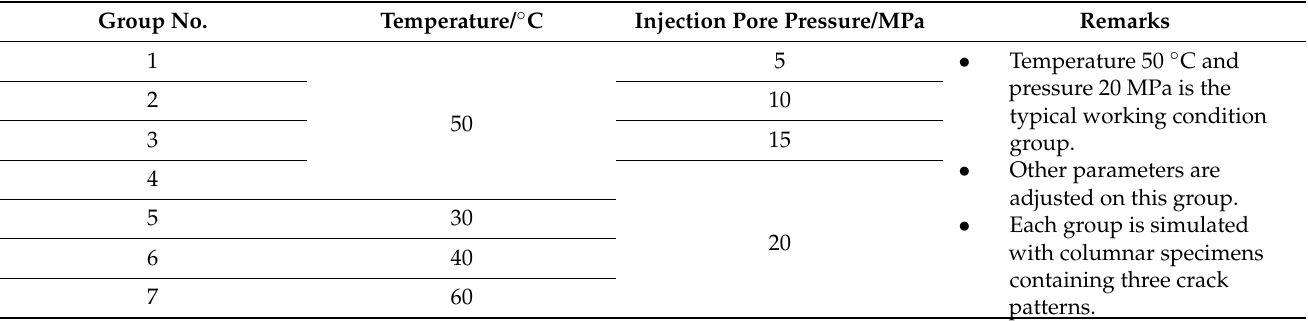
Table 2. Parameter settings for each group of the simulation